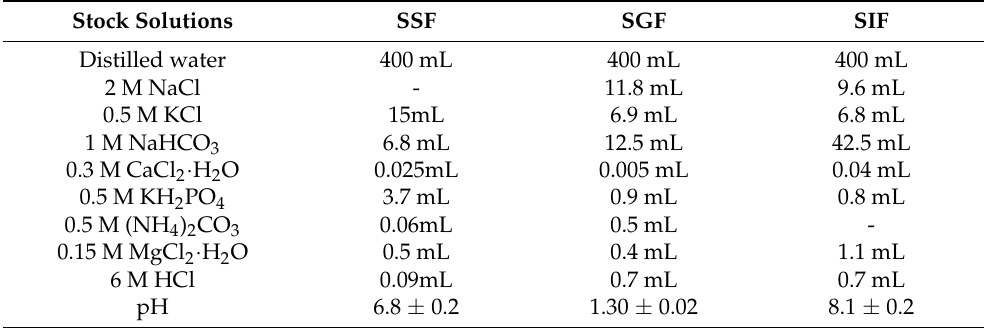
Table 2. Composition of Simulated salivary fluid (SSF), Simulated gastric fluid (SGF) and Simulated intestinal fluid